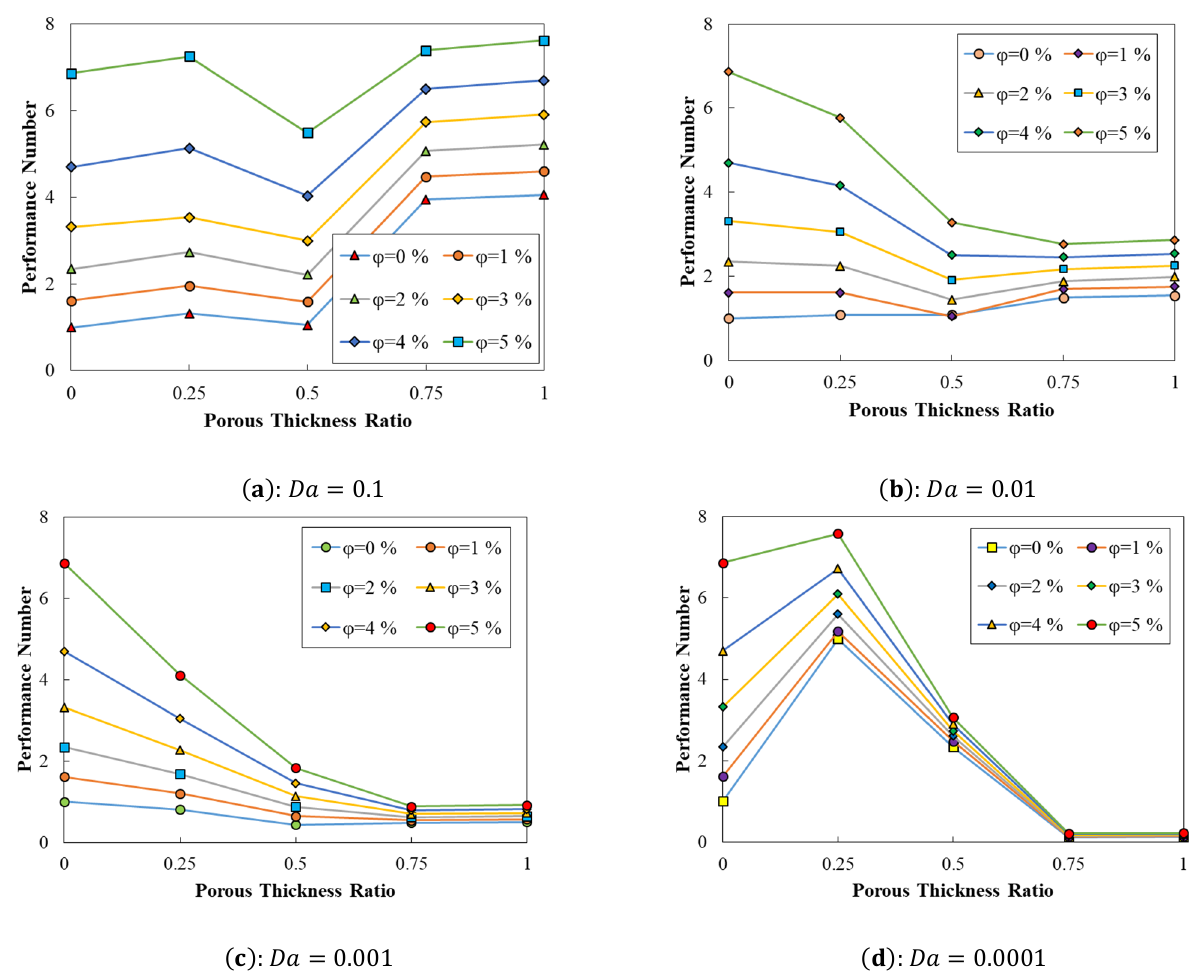
Figure 7. Performance number versus porous thickness ratio for diverse volume fractions at different Darcy numbers (case I).